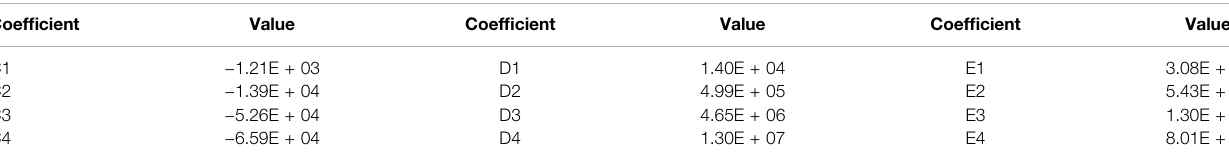
TABLE 6 | Coef fi cient values for f σ z ( x )